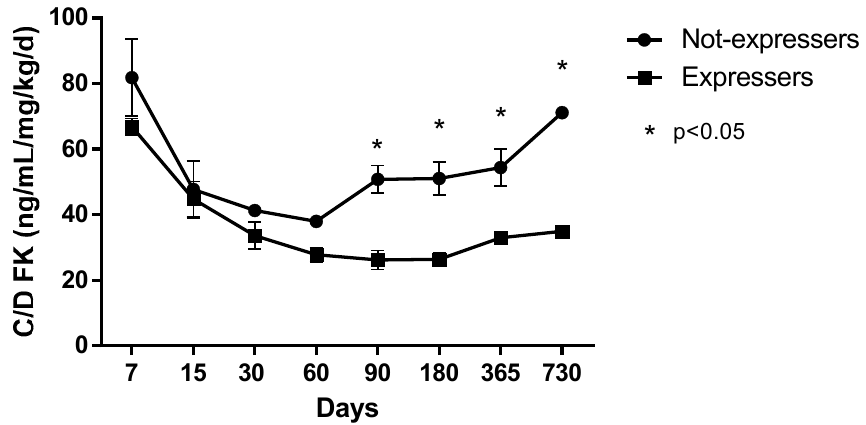
Figure 2. Co / dose of TAC according to the donor Figure 2. Co/dose of TAC according to the donor genotype.